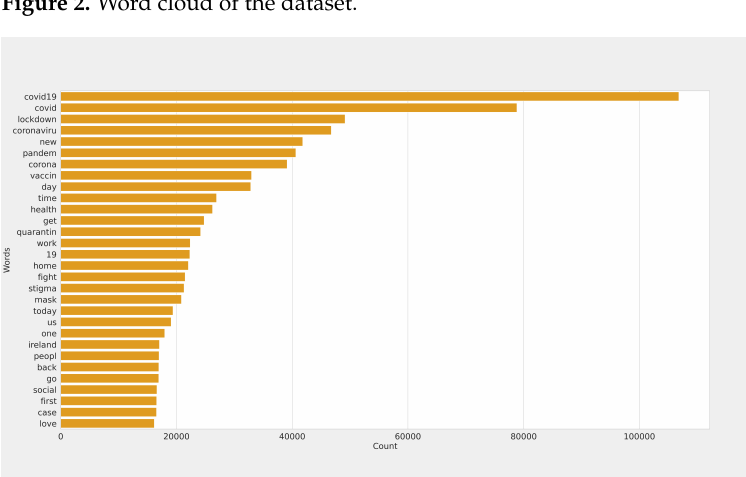
Figure 2. Word cloud of the dataset.